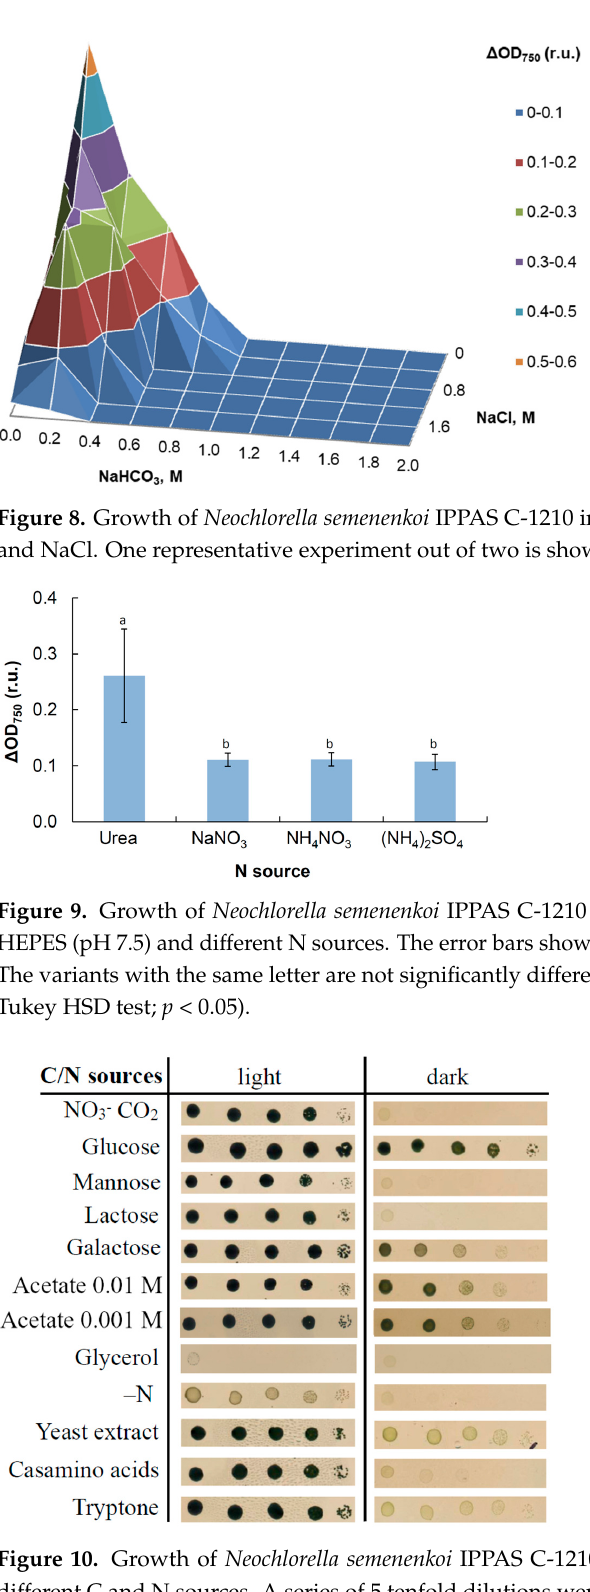
Figure 10. Growth of Neochlorella semenenkoi IPPAS C-1210 on modified BG-11 agar media with different C and N sources. A series of 5 tenfold dilutions were spotted on the modified BG-11 media with 20 mM HEPES (pH 7.5) and containing different nitrogen sources (nitrate, 0.01% yeast extract, 0.01% casamino acids, and 0.01% tryptone) and carbon sources (atmospheric carbon dioxide, 0.1% glucose, 0.1% mannose, 0.1% lactose, 0.1% galactose, 0.1% glycerol, 0.001 M acetate, and 0.01 M acetate). The variants grown on standard BG-11 medium with 20 mM HEPES (pH 7.5) were used as a control. One of three repetitions is